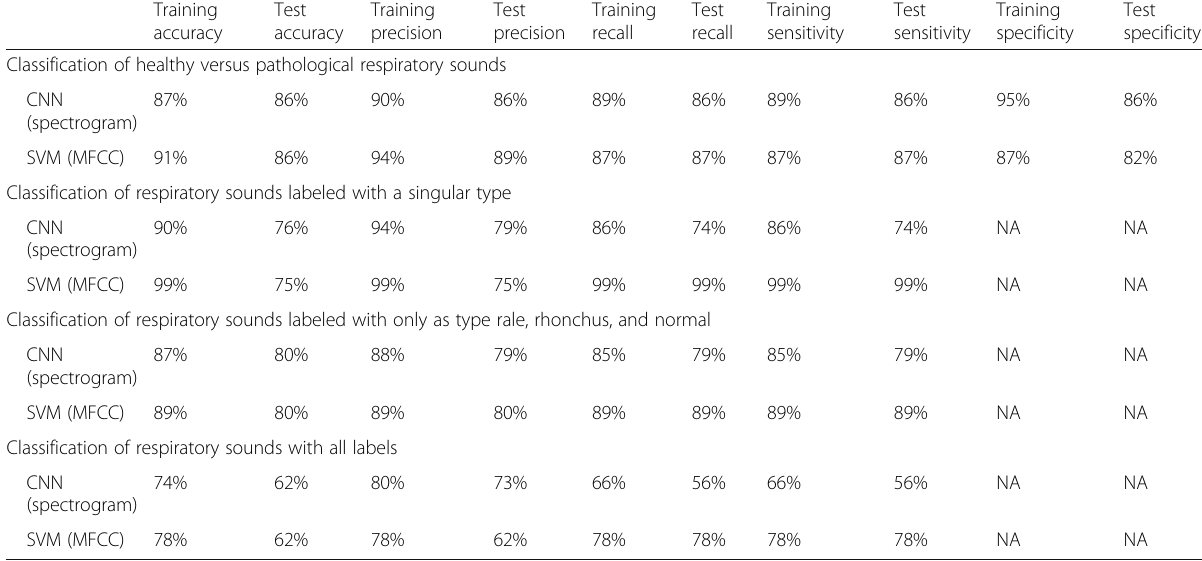
Table 1 Experiment